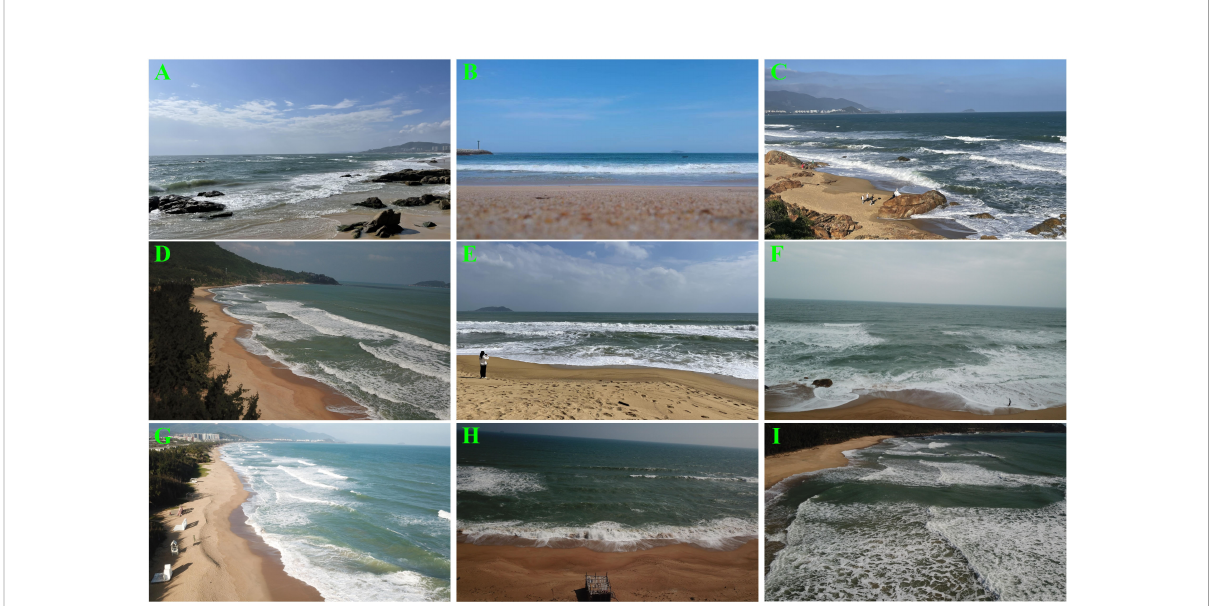
FIGURE 1 A collection of pictures of beach scenes. According to our observations, there are clear rip currents in pictures (D, F, I) , while there are no clear rip currents in pictures (A-C, E, G, H) . But the vast majority of people do not understand rip currents and they have dif fi culty in detecting them, these targets do not have a clear